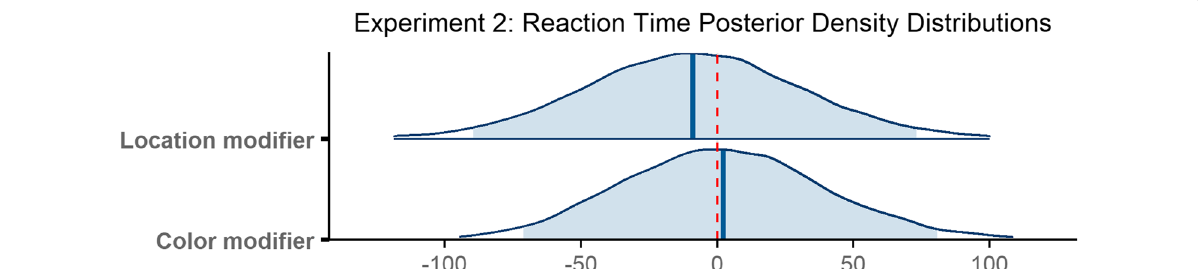
Fig. 12 Posterior density distributions for reaction time β parameter estimates for each level of the fixed effect relative to the reference level. Light blue shaded regions indicate the 95% credible interval and blue vertical lines indicate the mean of the distribution. The red vertical dashed line highlights 0 on the x axis. If the red line falls within the light blue shaded region, the estimate is not reliably different from zero and interpreted as a null